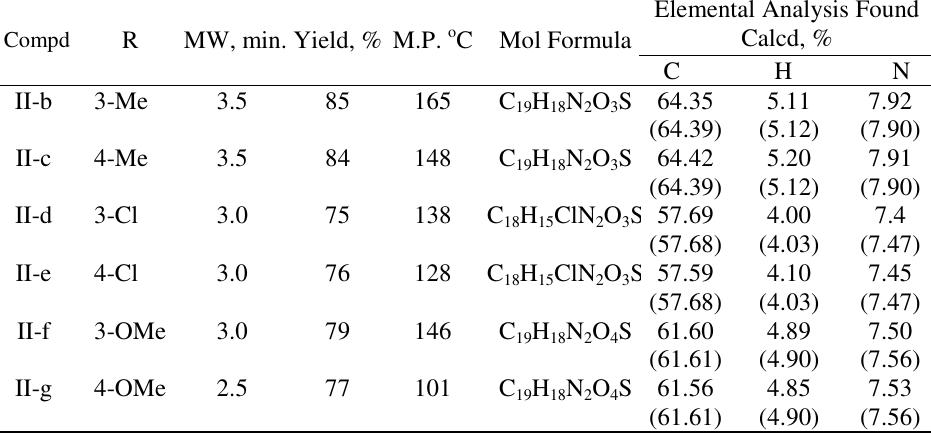
Table 1. Physical and Analytical data of the compounds